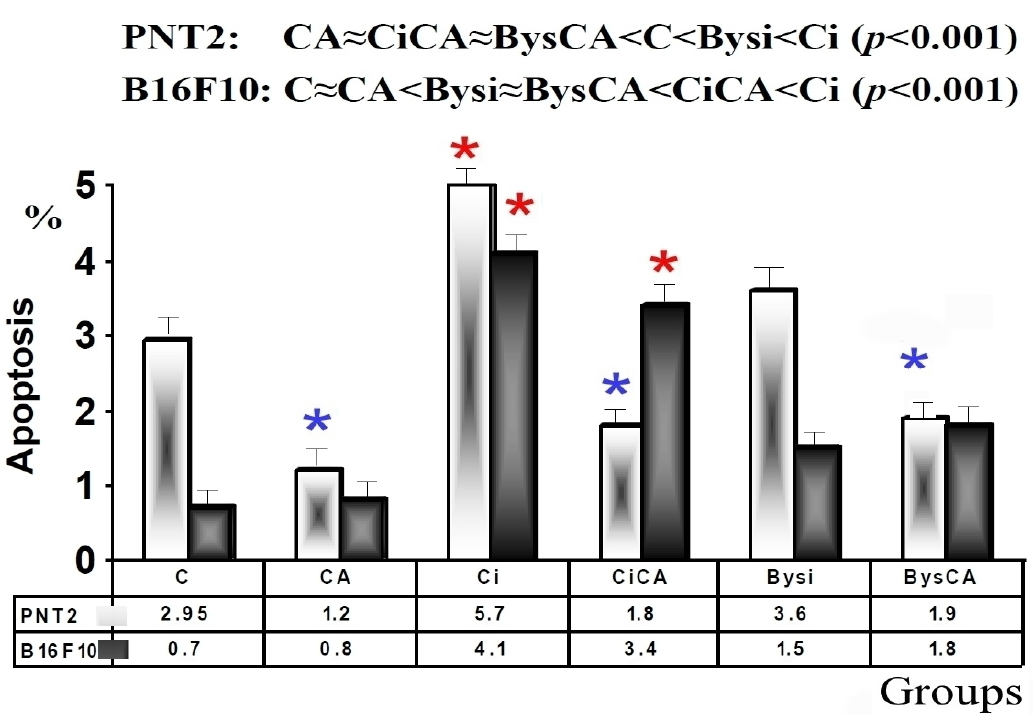
Figure 8. Percentage of PNT2 and B16F10 cells in apoptosis 48h after exposure to 20 Gy of X-rays (C, control; CA, treated with carnosic acid; Ci, irradiated control; CiCA, irradiated previously treated with carnosic acid; Bysi, treated with previously irradiated serum; BysCA, treated with irradiated serum previously treated with carnosic acid) (* p < 0.001 versus C; * p < 0.01 versus C). Data are mean ± SE of six independent experiments.